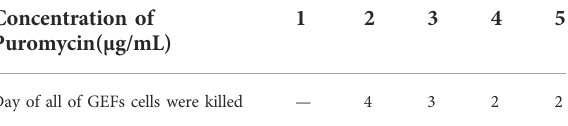
TABLE 3 Days of fully causing death at different concentrations of